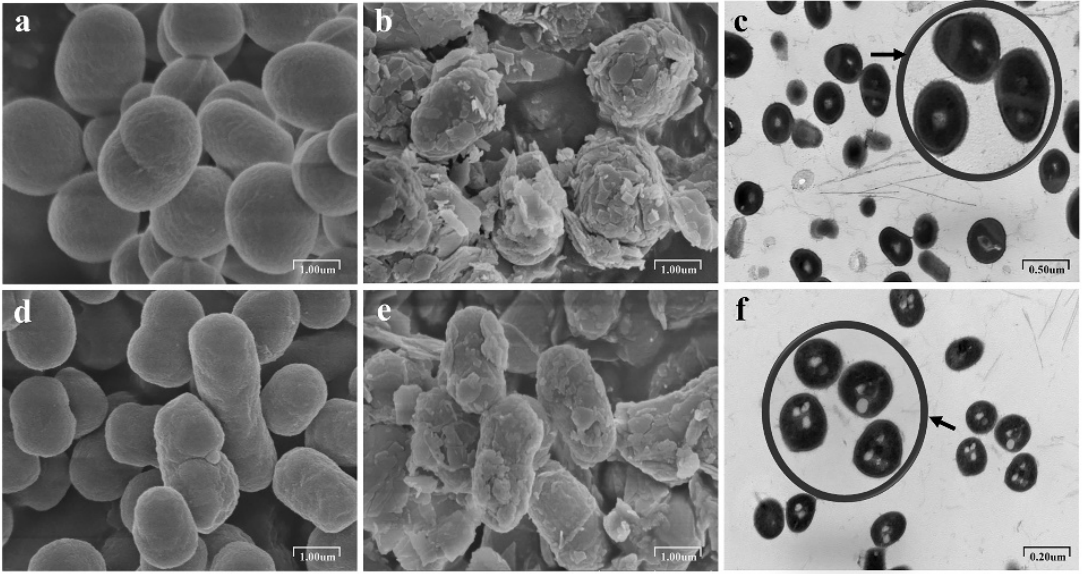
Figure 2. Cell surface morphologies of strains ZM05 ( a ) and ZM06 ( d ) without Cd(II) stress; cell surface morphologies of strains ZM05 ( b ) and ZM06 ( e ) with Cd(II) stress; TEM photographs of strains ZM05 ( c ) and ZM06 ( f ) after adsorption of Cd(II).